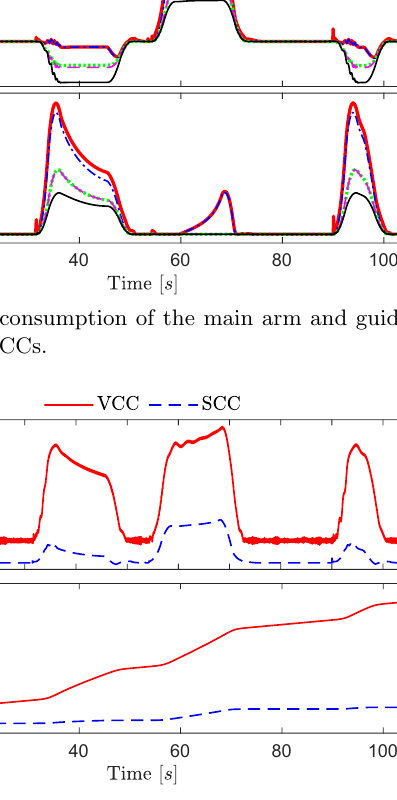
Figure 32: Energy comparison between benchmark system and self-contained system.